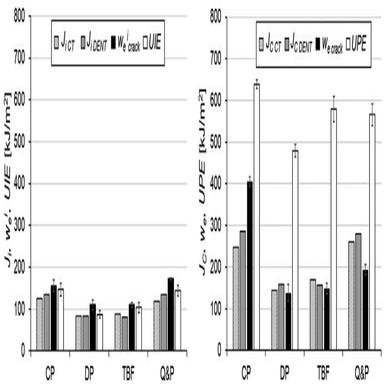
Summary of crack initiation (left) and crack propagation resistance (right) parameters. Standard deviation is indicated when available.